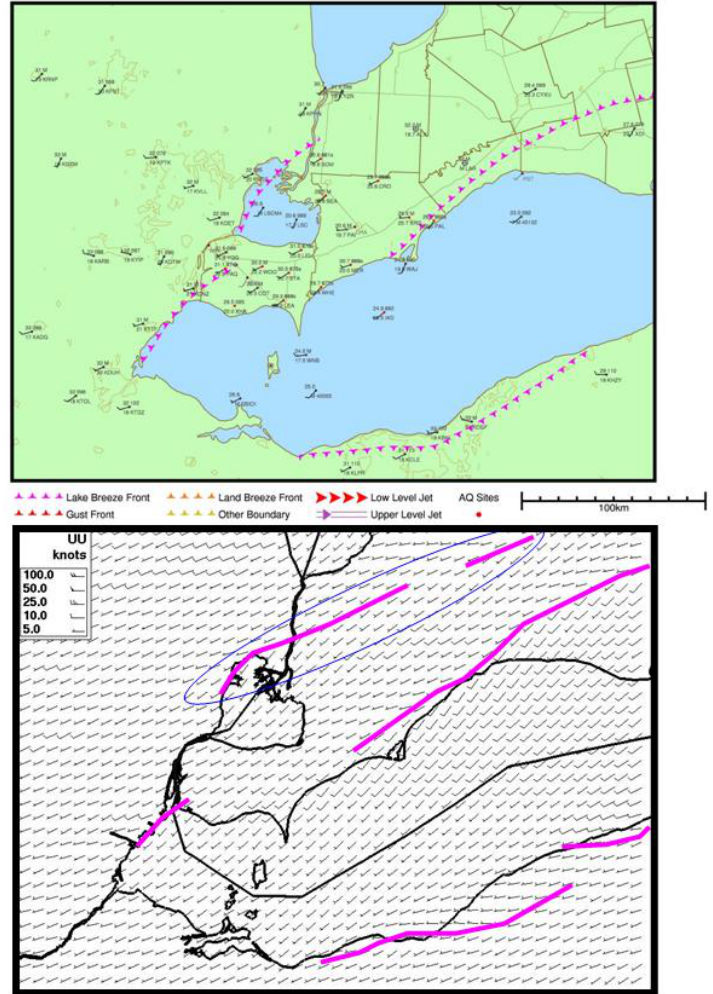
Fig. 11. (a) Meso-analysis lake-breeze front locations on 8 July, 17:00 UT (01:00p.m. local time); (b) model-predicted surface wind field and convergence